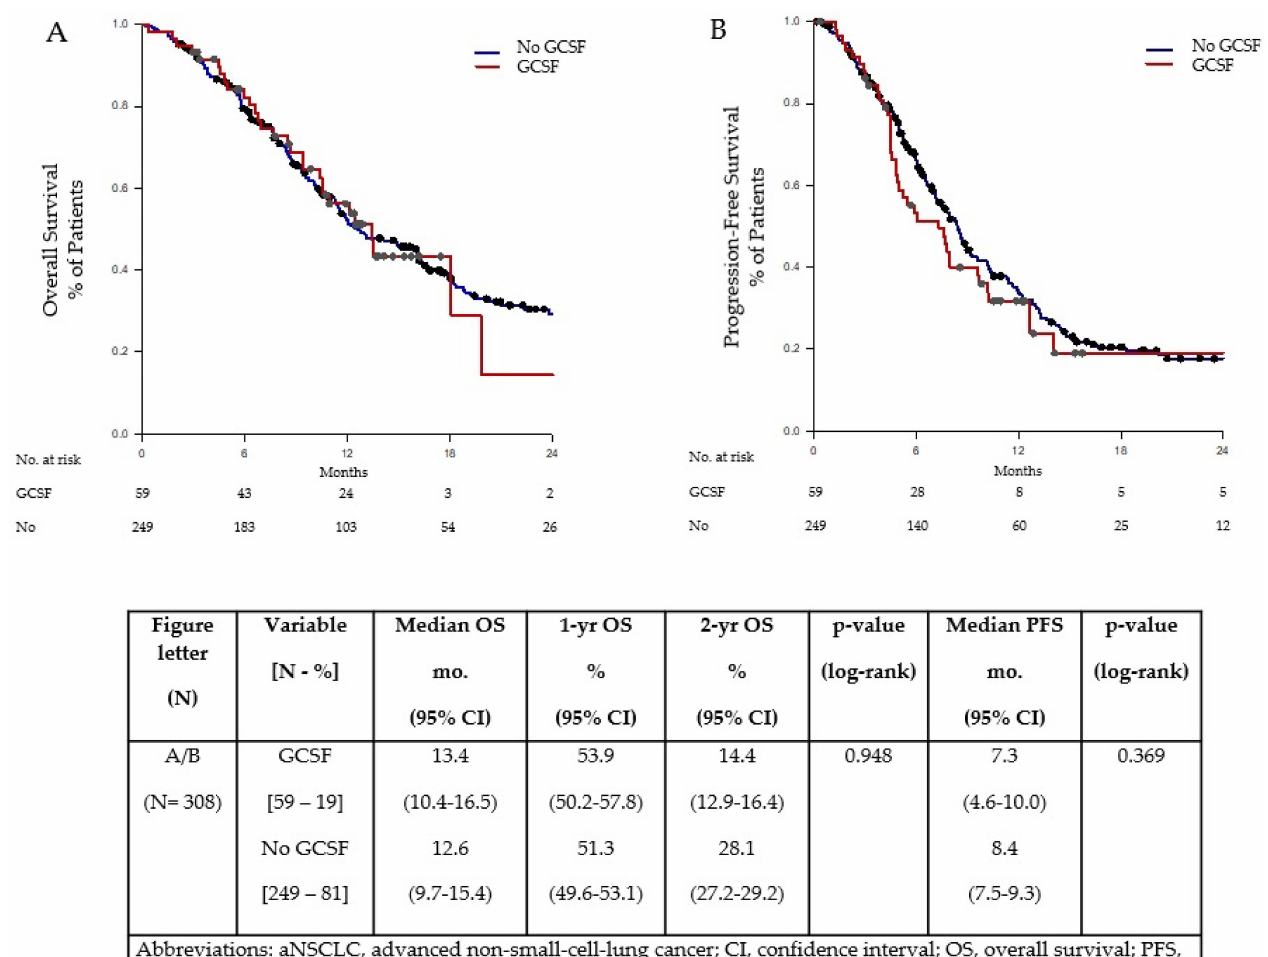
Figure 1. OS ( A ) and PFS ( B ) by GCSF use in patients with aNSCLC treated with